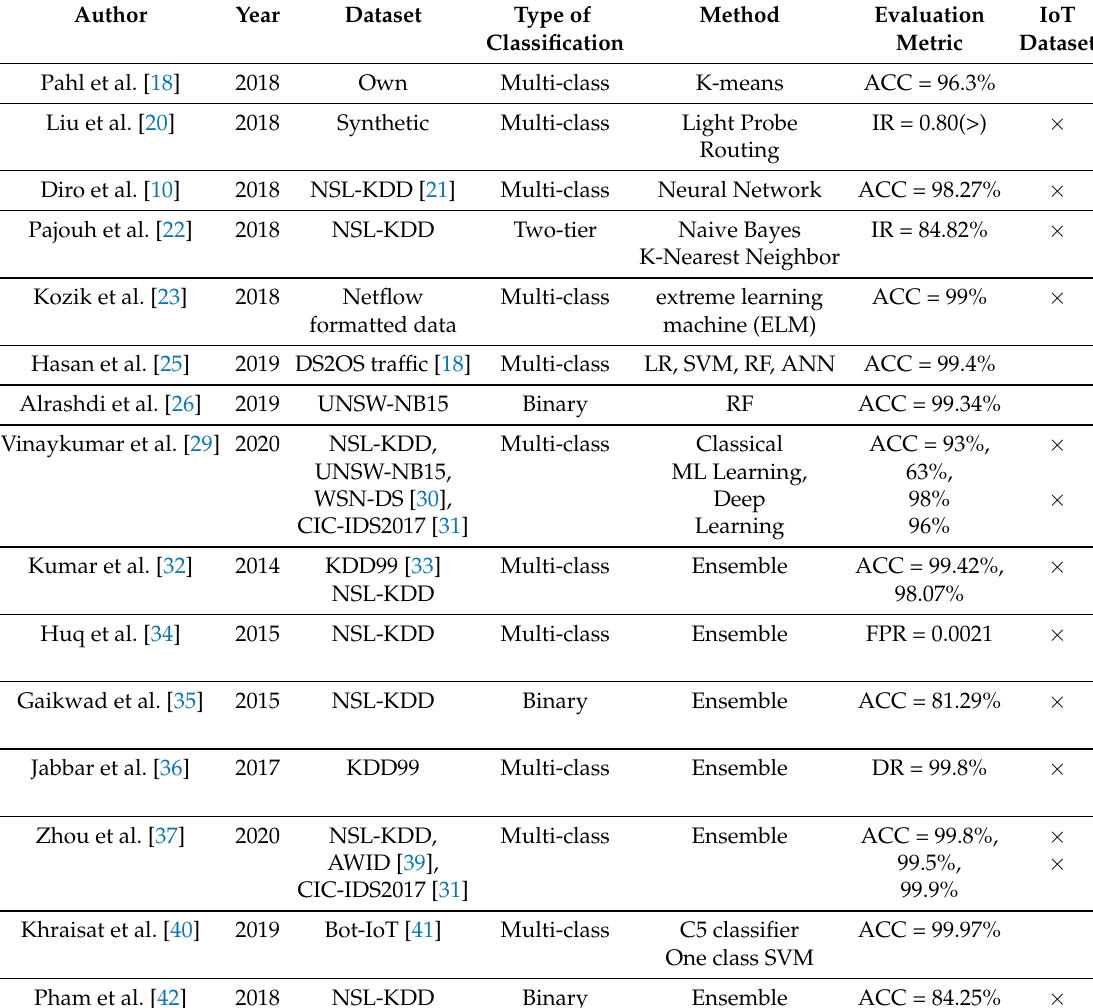
Table 1. List of notable works that use machine learning (ML) and ensemble techniques for intrusion and anomaly detection. Note that not all the works deal with IoT datasets; however, they are presented here for their use of traditional or ensemble ML